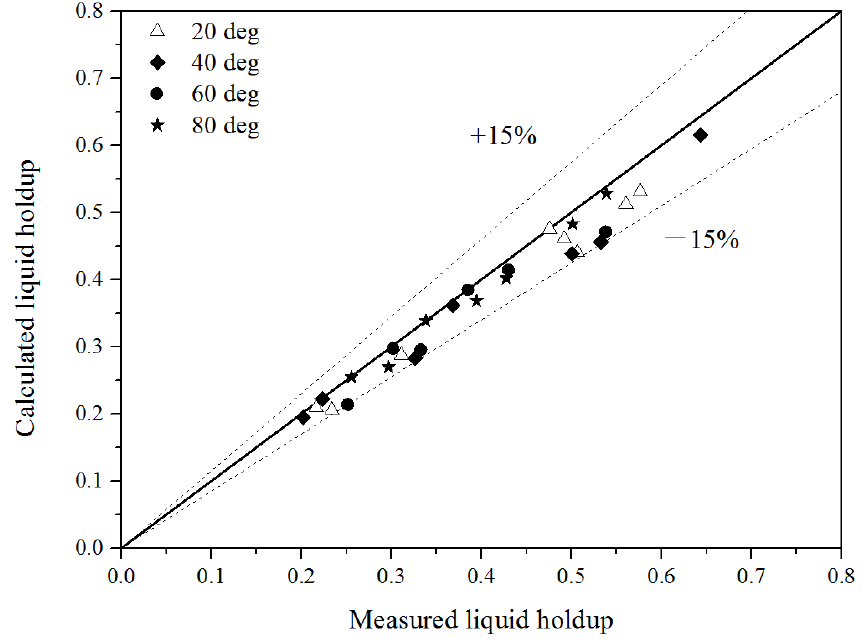
Figure 6. Comparison of the prediction and experiment for liquid holdup for the No. 2 experiment.